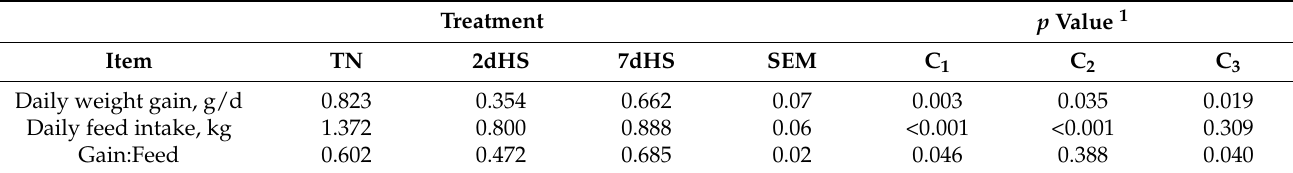
Figure 1. Ambient temperature ( A ) and relative humidity ( B ) recorded at 15 min intervals, and calculated heat index ( C ). Table 3. Productive performance variables of growing pigs under thermoneutral (TN), 2 or 7 days of heat stress exposition (2dHS or